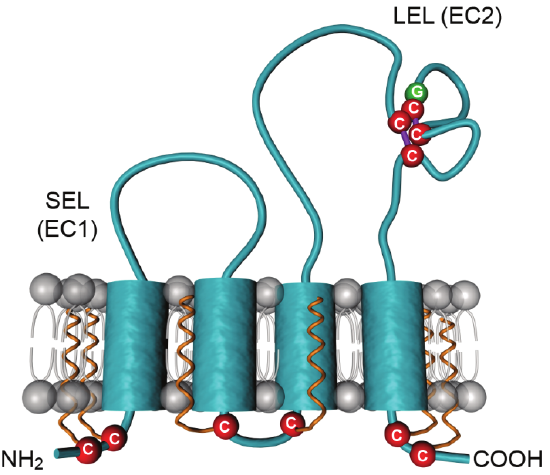
Figure 3. Schematic representation of the tetraspanin CD81. CD81 is composed of four transmembrane domains and two extracellular loops designated the small extracellular loop (SEL or EC1) and the large extracellular loop (LEL or EC2). Conserved cysteines are highlighted in red. The conserved CCG motif, which forms disulfide bridges (purple lines) with additional cysteines, is shown. Palmitoylations on six juxtamembranous cysteines are shown in